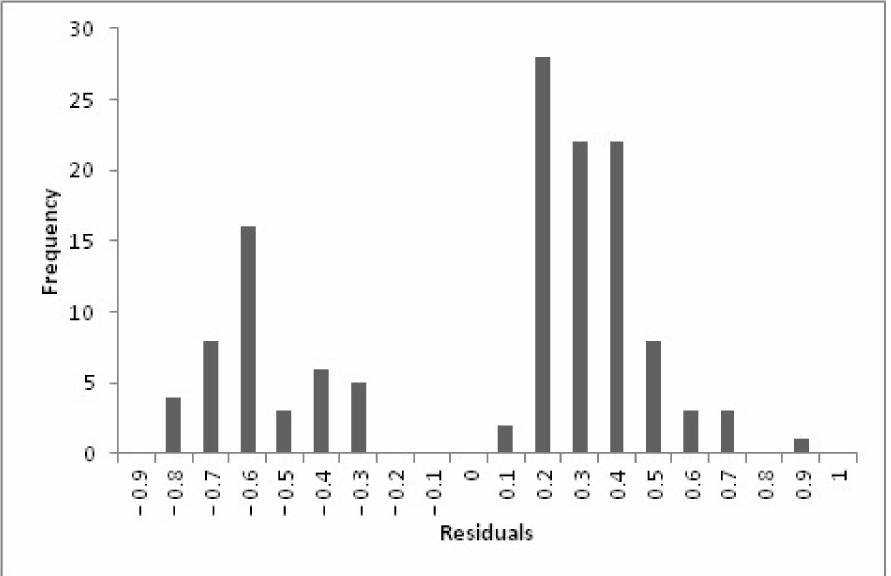
Figure 5. Histograms of residuals for the model for grade ≥ 2 acute salivary